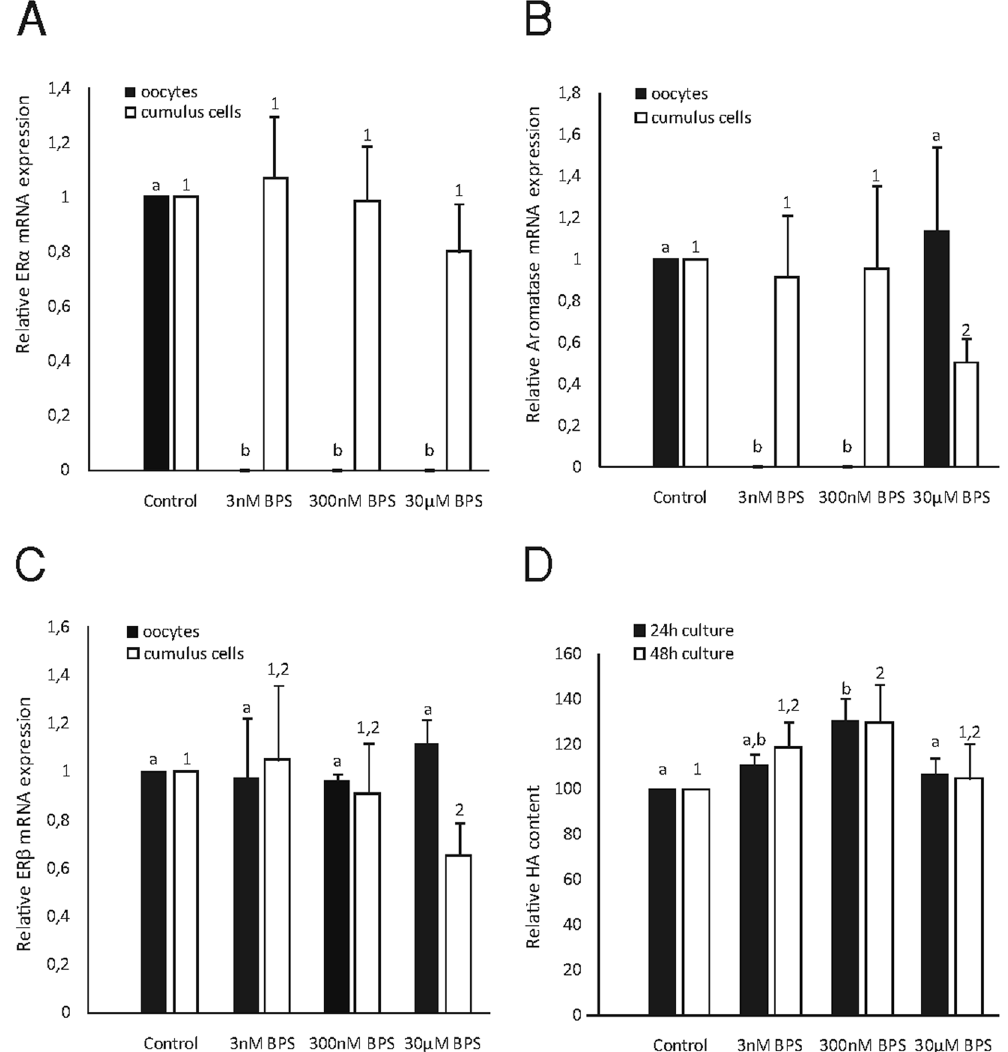
Figure 3. Effects of BPS on mRNA expression levels of selected genes and cumulus cell expansion. Effects of BPS (3 nM, 300 nM, and 30 μ M) on the relative mRNA expression of ( A ) ER α , ( B ) ER β , and ( C ) aromatase in oocytes and cumulus cells cultured for 48 h in vitro . The data are expressed from three independent experiments, with a total of n = 150 oocytes per group. Different letters and numbers denote the statistical significance among experimental groups for oocytes and cumulus cells, respectively (P < 0.05). ( D ) Effects of BPS on HA content in COCs after 24 and 48 h of in vitro culture. Different letters and numbers denote the statistical significance among experimental groups for 24 and 48 h of in vitro culture, respectively (P <